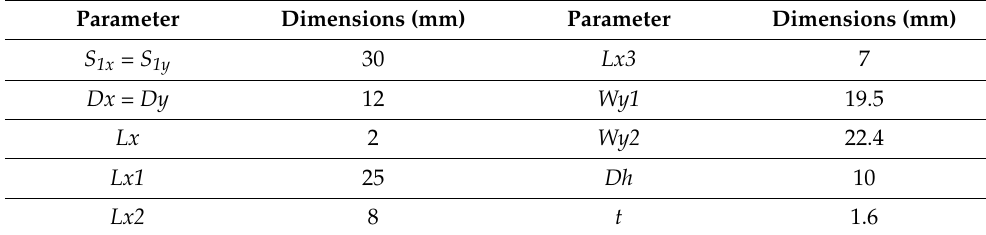
Figure 1. Antenna views, ( a ) top, and ( b ) perspective. Table 1. Antenna Mechanical Dimensions.